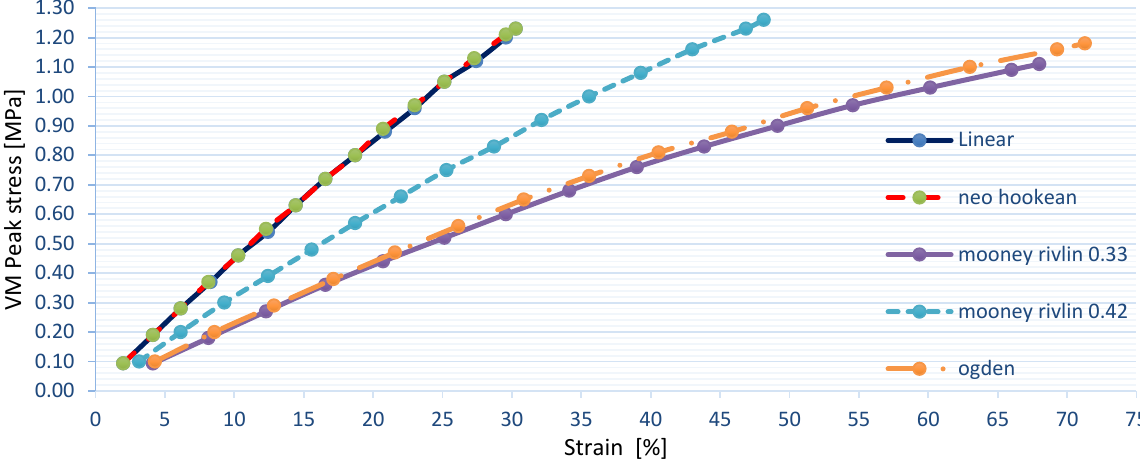
Graph 3 Material models: VM Shear stress vs strain results for 1:1 aspect ratio silicone joints.